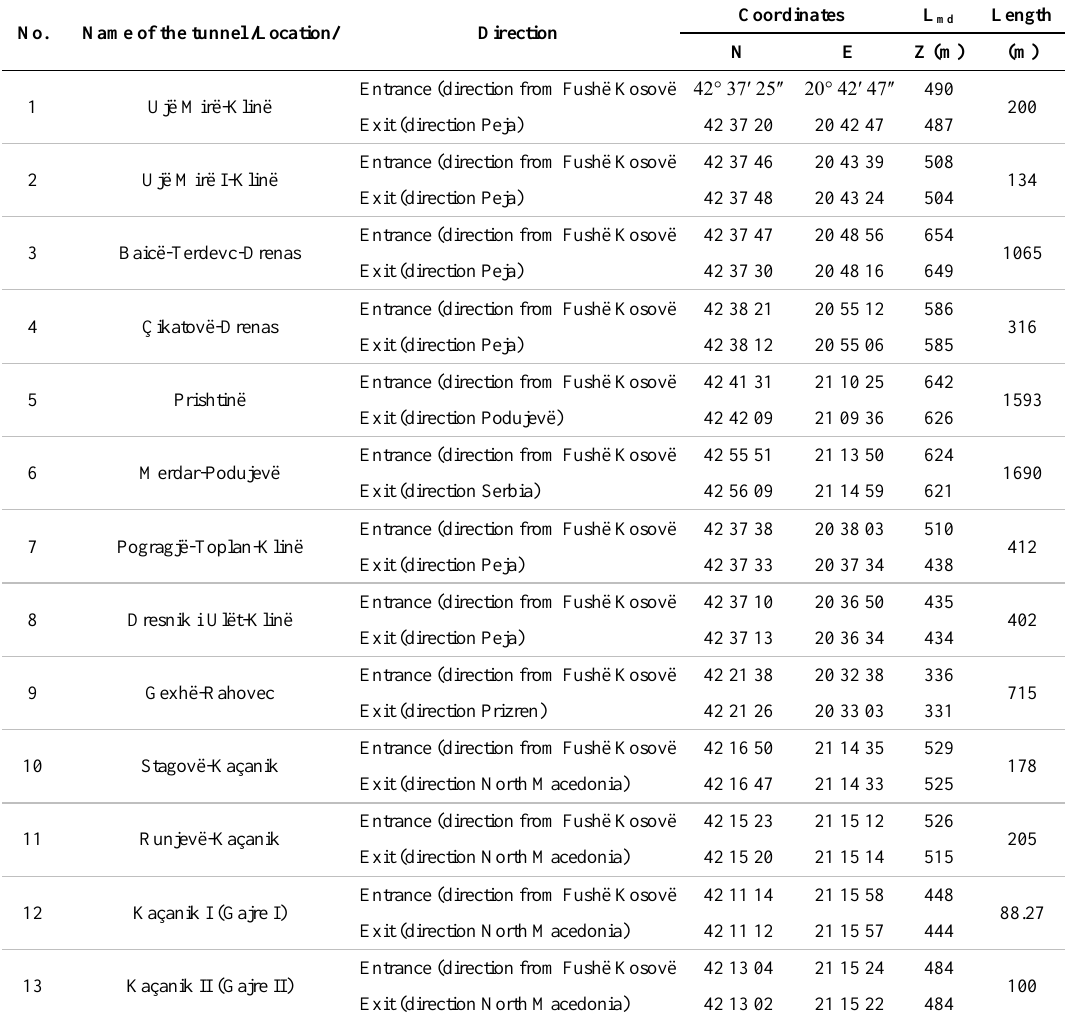
Table 4. Characteristic data of